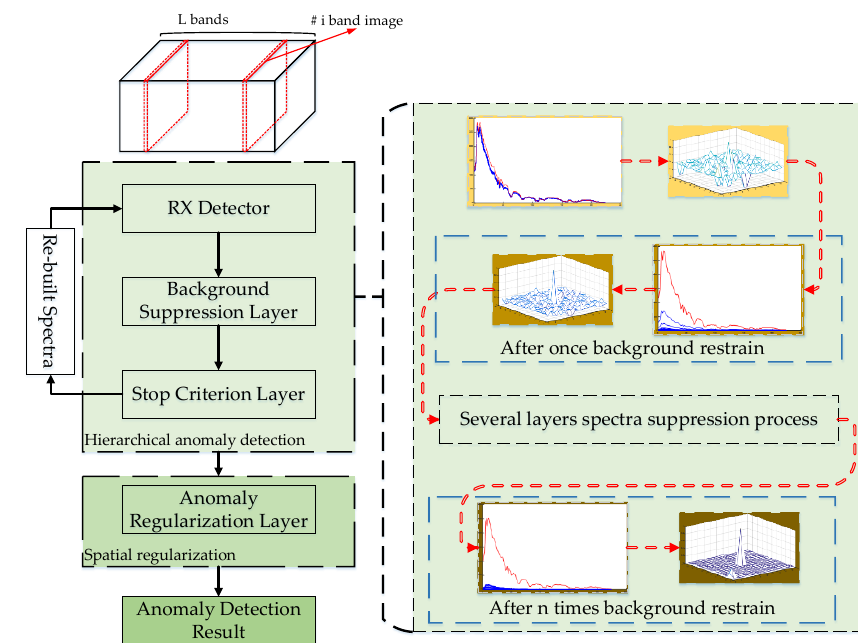
Figure 1. Framework of the proposed hierarchical Reed-Xiaoli (H-RX) anomaly detection algorithm. For the former phase, a background suppression layer is developed to restrain the background spectra of the input hyperspectral data and a stop criterion layer is designed to determine whether the data need further detection processing. For the anomaly detection result regularization phase, the